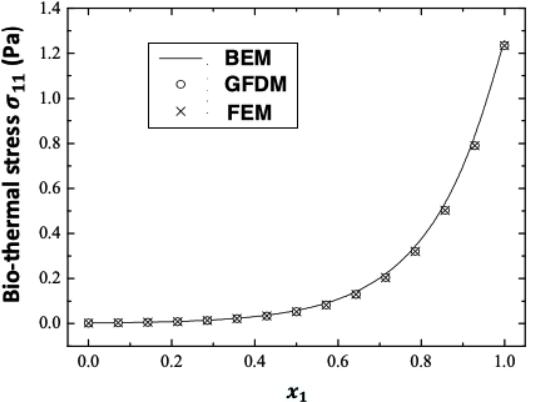
Figure 6. Biothermal stress 𝝈 𝟏𝟏 fluctuations along the 𝒙 𝟏 – axis for various techniques. Table 1. CPU times and iterations number for CA-Arnoldi, D-K and GMSS.